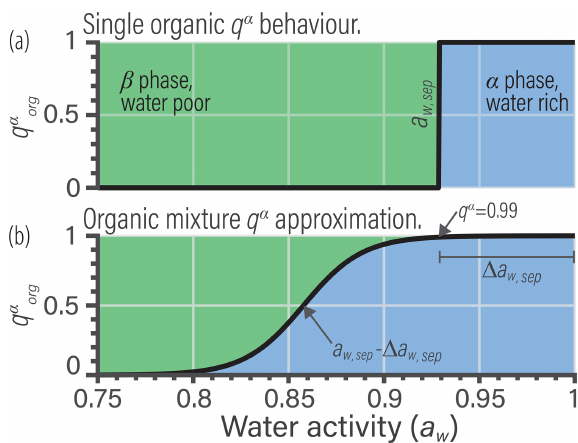
Figure 5. Example of the liquid–liquid phase partitioning for 1- hexanol as a function of water activity, expressed by q α org . The q α org value is only relevant for mixtures that exhibit a miscibility